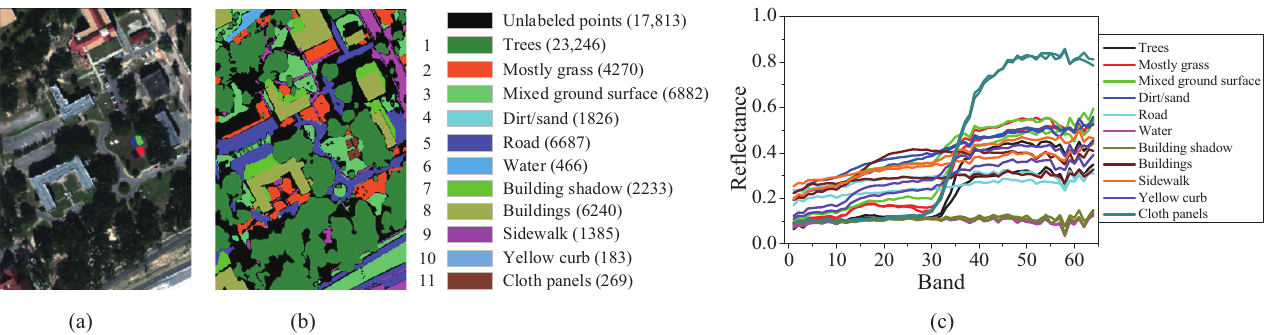
Figure 4. MUUFL hyperspectral image. ( a ) False color image. ( b ) Ground truth. ( c ) Spectral curves. (Note that the number of samples for each class is shown in